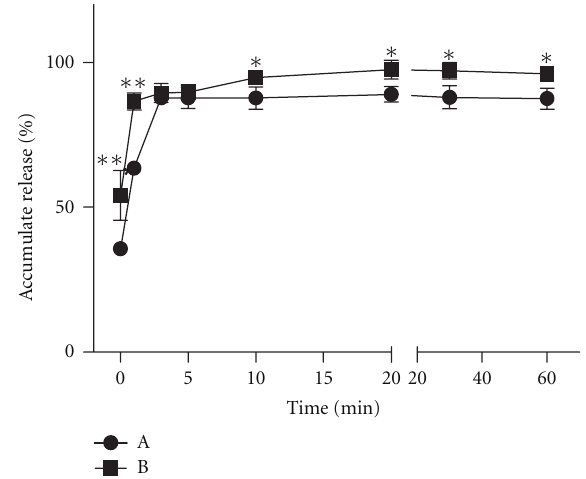
Figure 8: In vitro release profile of tranexamic acid-loaded composite particle A: in PBS (pH 7.4); B: in anticoagulated blood plasma. Each data point represents the mean of 3 samples ± SD; compared with A: ∗ P < 0 . 05, ∗∗ P < 0 .